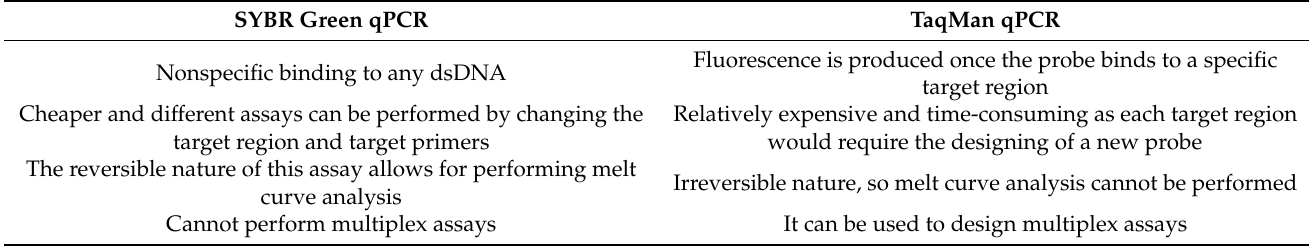
Table 1. Comparison of SYBR Green and TaqMan qPCR